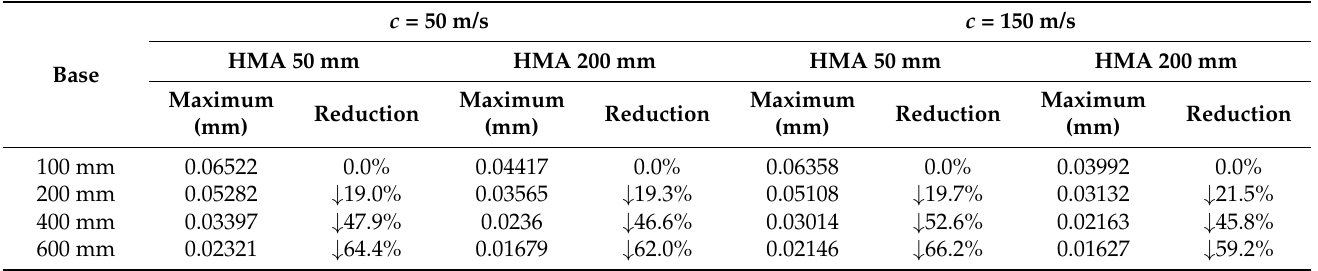
Figure 11. Effect of the base thickness on the vertical displacement fluctuation amplitude along the x -axis, induced by a moving Gaussian load: ( a ) cases for a 50mm-thick HMA layer, with a speed of c = 50 m/s; ( b ) cases for a 50 mm-thick HMA layer, with a speed of c = 150 m/s; ( c ) cases for a 200 mm-thick HMA layer, with a speed of c = 50 m/s; and ( d ) cases for a 200 mm-thick HMA layer, with a speed of c = 150 m/s. Table 2. Reduction in the maximum displacement for different variations in the base layer